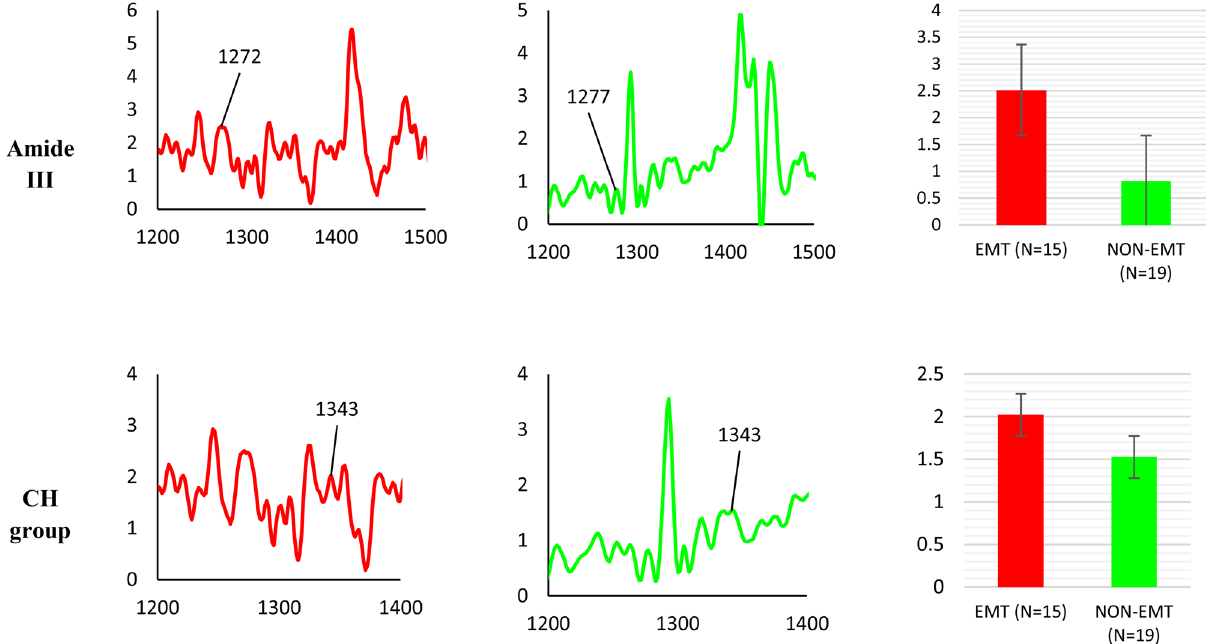
Figure 7. Summary of protein vibrational bands observed for waxed samples (Group 2) of EMT and non- EMT breast cancer tissue. For each case, the x-axis represents the wavenumber while the y-axis represents the intensity. The colour black represents the non-lesional tissues, while red represents EMT tissues and green represents non-EMT tissues. Comparison of the relative intensity of protein Raman bands for waxed samples of EMT and non-EMT breast tissue us depicted in the bar charts. Each column represents the average of spectra for each type of tissue. The value of N represents the number of Raman spectra acquired for each sample, shown within the brackets. The error bar represents standard deviation. Note: the x-axis represents the tissue type and y-axis is Raman intensity. No statistically significant differences between the groups are reported by the t-test.